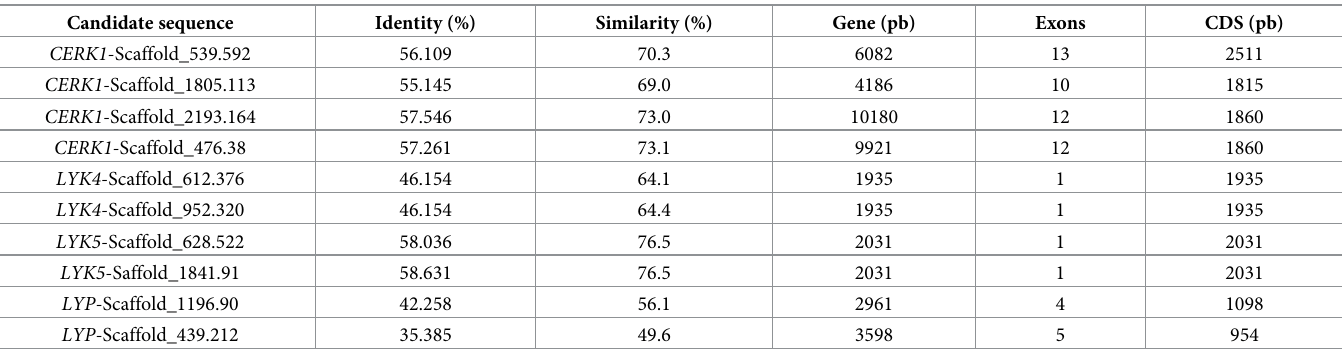
Table 3. BLASTp and nucleotide characterization of candidate sequences in C . arabica .